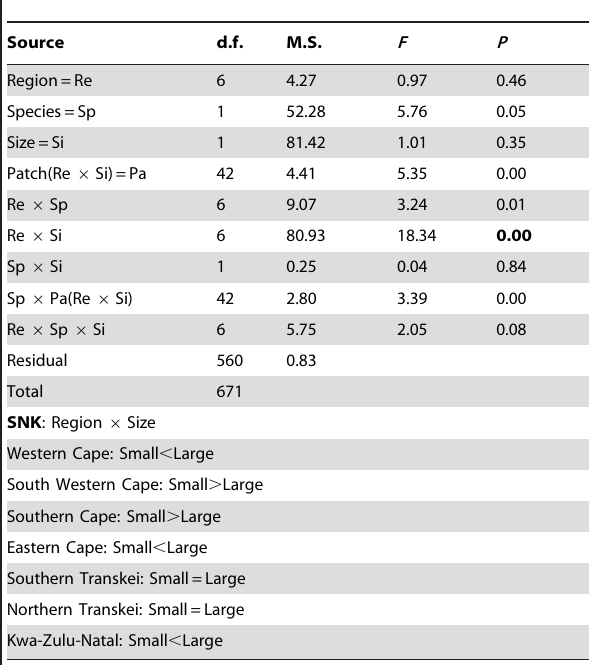
Table 2. Analysis of variance comparing densities of juvenile Siphonaria concinna and S. serrata in 7 regions along the 1500 km of the limpets’ biogeographic range in 4 small and 4 large